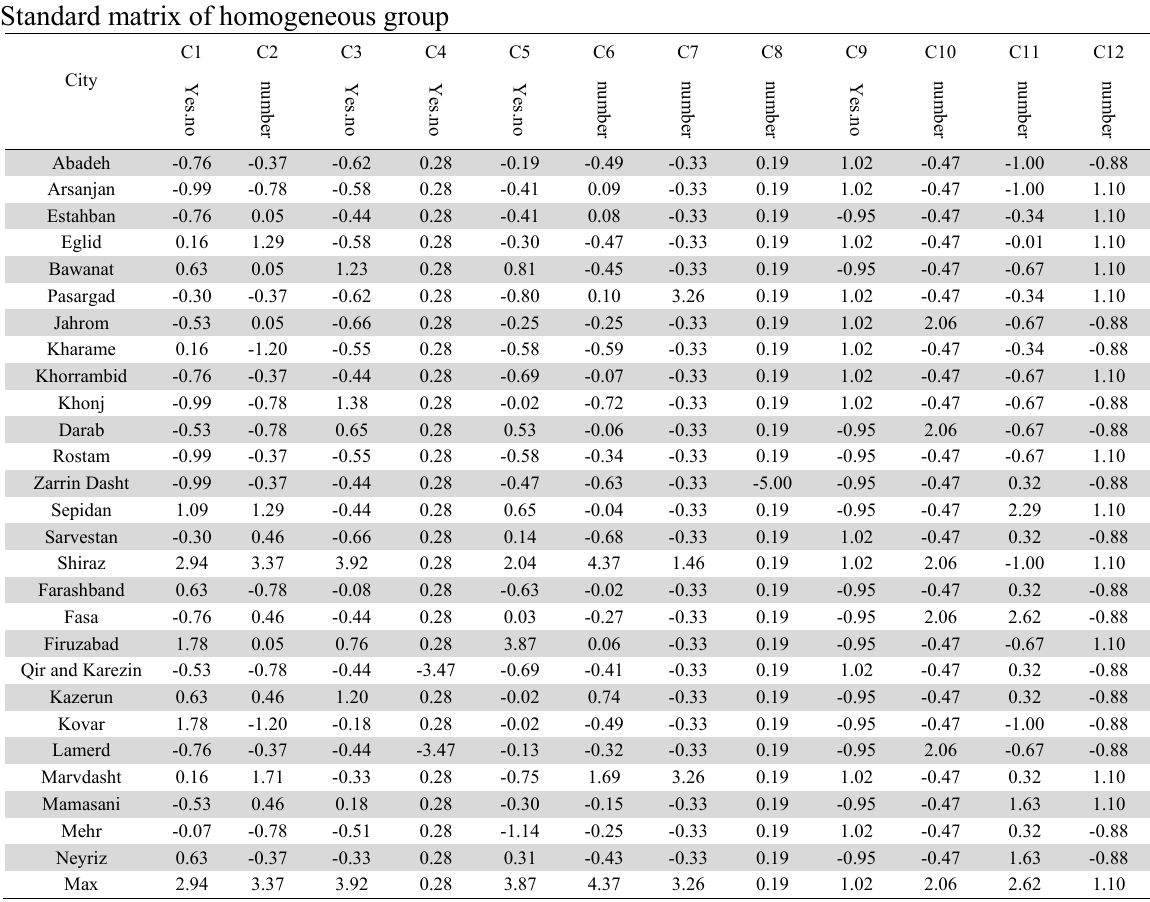
Standard matrix of homogeneous